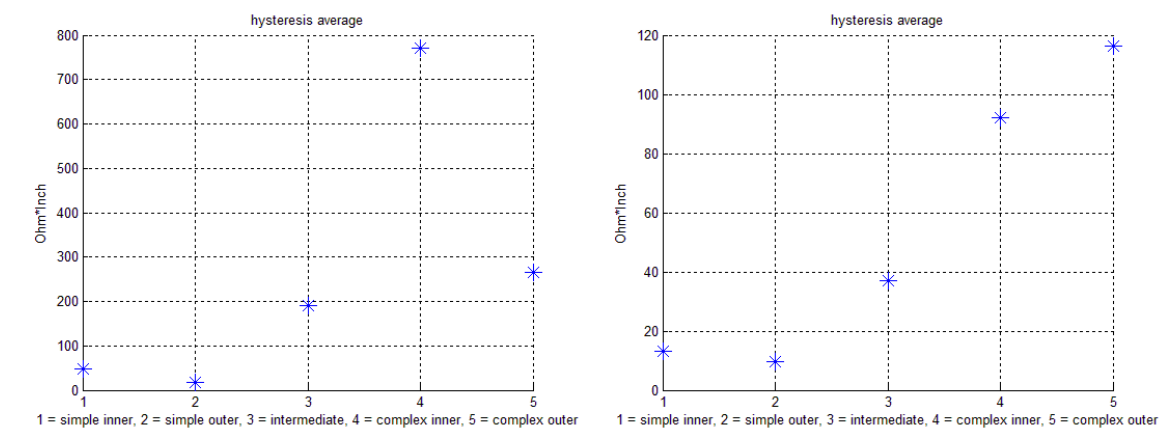
Figure 21. Hysteresis averaged over fabrics: ( left ) un-insulated case; ( right ) insulated